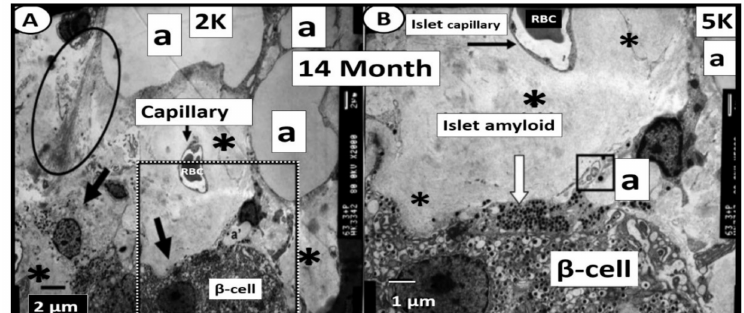
Figure 11. β -cell loss and near-complete islet amyloid replacement in 14-month-old HIP rat islets. There were very few β -cells remaining in 14 month-old models and most islets demonstrated near-complete replacement with islet amyloid and fatty infiltration of islets was prominent with large lipid droplets (a) in 14-month-old models in (Panels ( A , B )). Oval in panel ( A ) encloses an early change in intra-islet fibrosis. Remaining β -cells were atrophic and capillaries and pericytes were decreased. The remaining pericytes demonstrated multiple lipid droplets in their cytoplasm similar to lipid droplets within the islets (not shown). Panel ( B ) is a higher mag of the dashed boxed in region in panel ( A ) [65]. Magnification × 2000 and × 5000 in Panels ( A , B ), respectively; scale bar = 2 µ m in panel ( A ) and 1 µ m panel ( B ). a = adipose lipid droplets; open and closed arrows = β -cell; K =